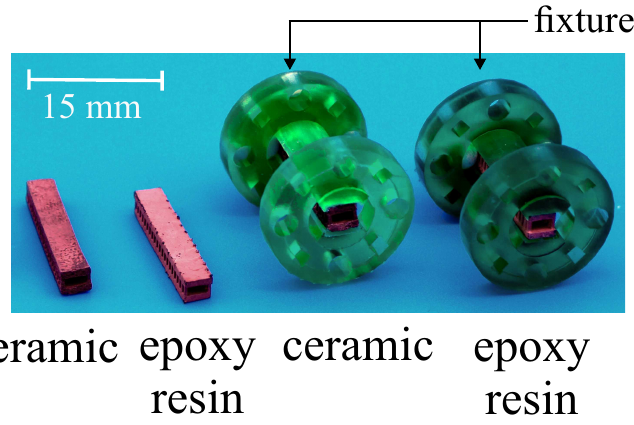
Figure 3. Photography of the different prototypes with ( right ) and without ( left ) fixtures for mounting